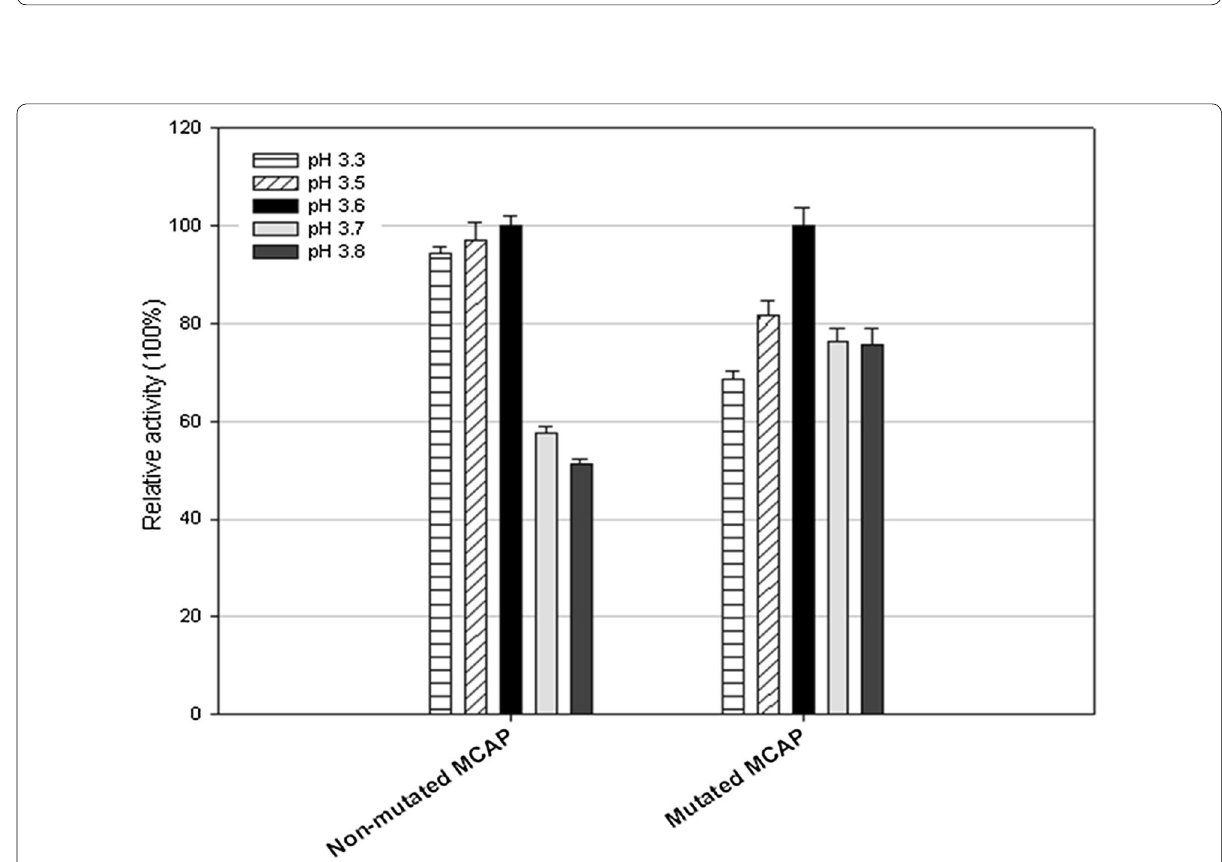
MCAP‑5, lane 3 X‑33/ +